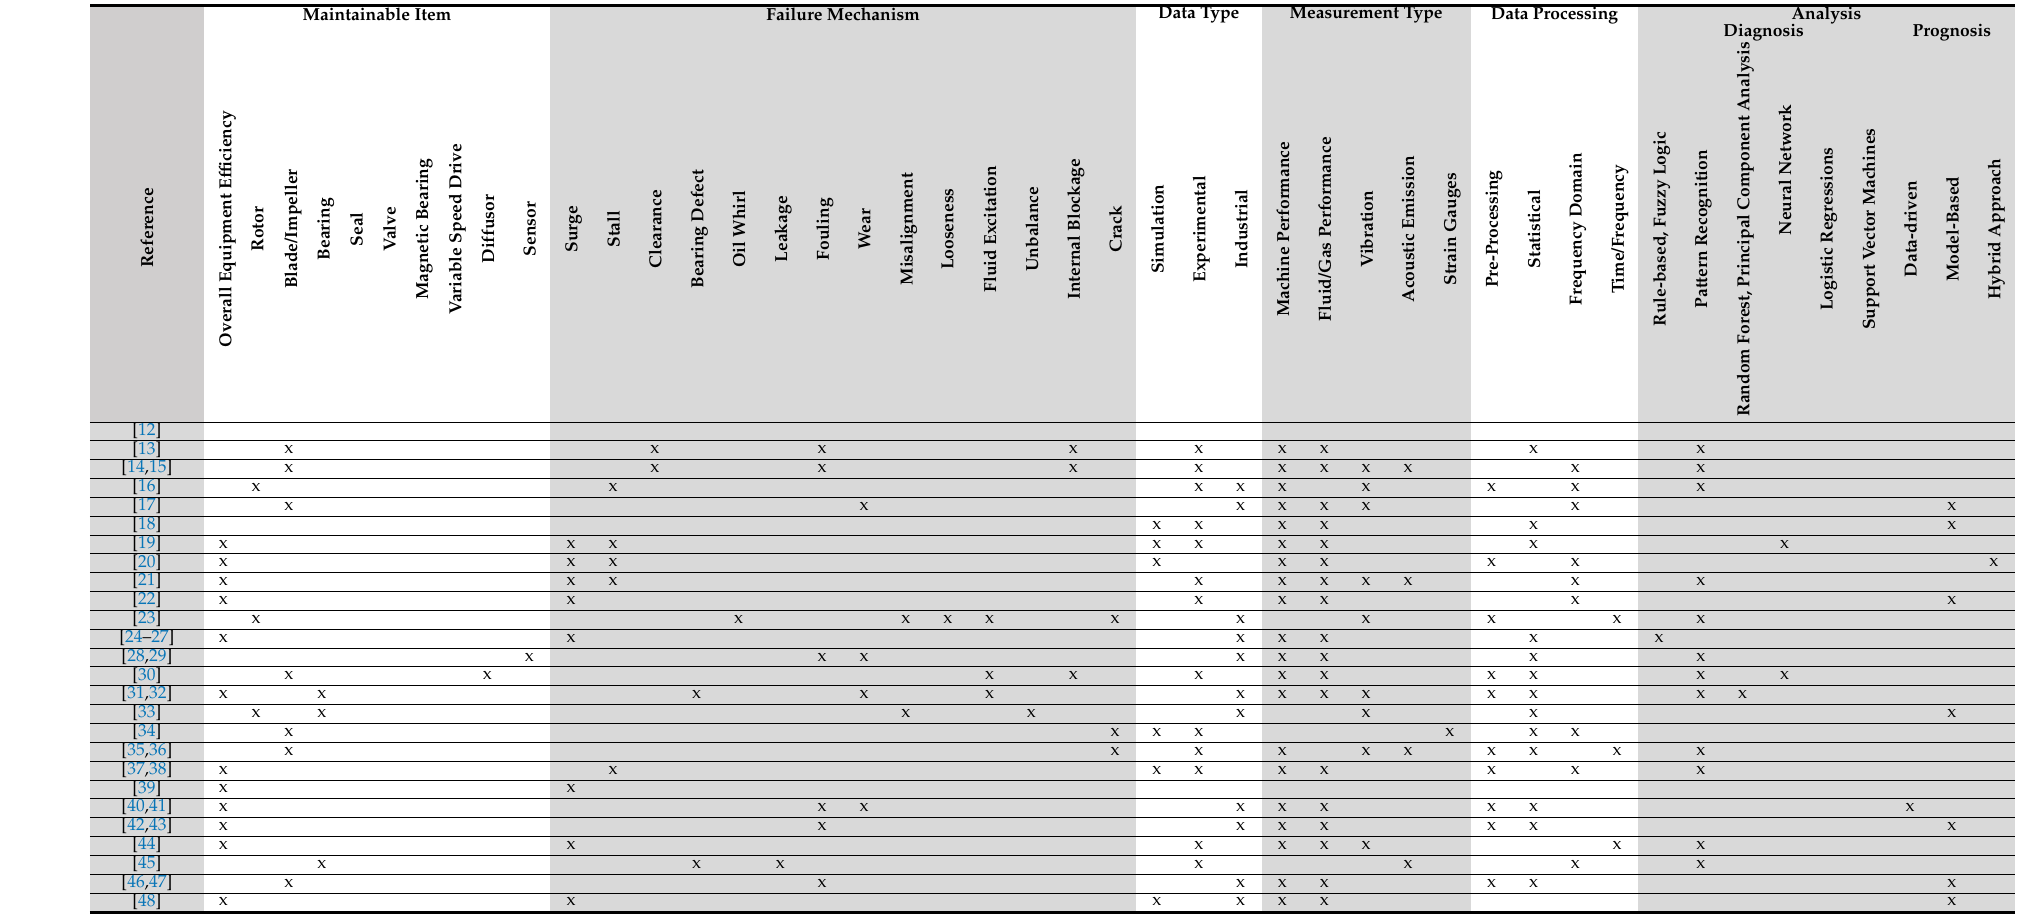
Table 2. A summary of state-of-the-art centrifugal compressor monitoring (i.e., predictive maintenance) and